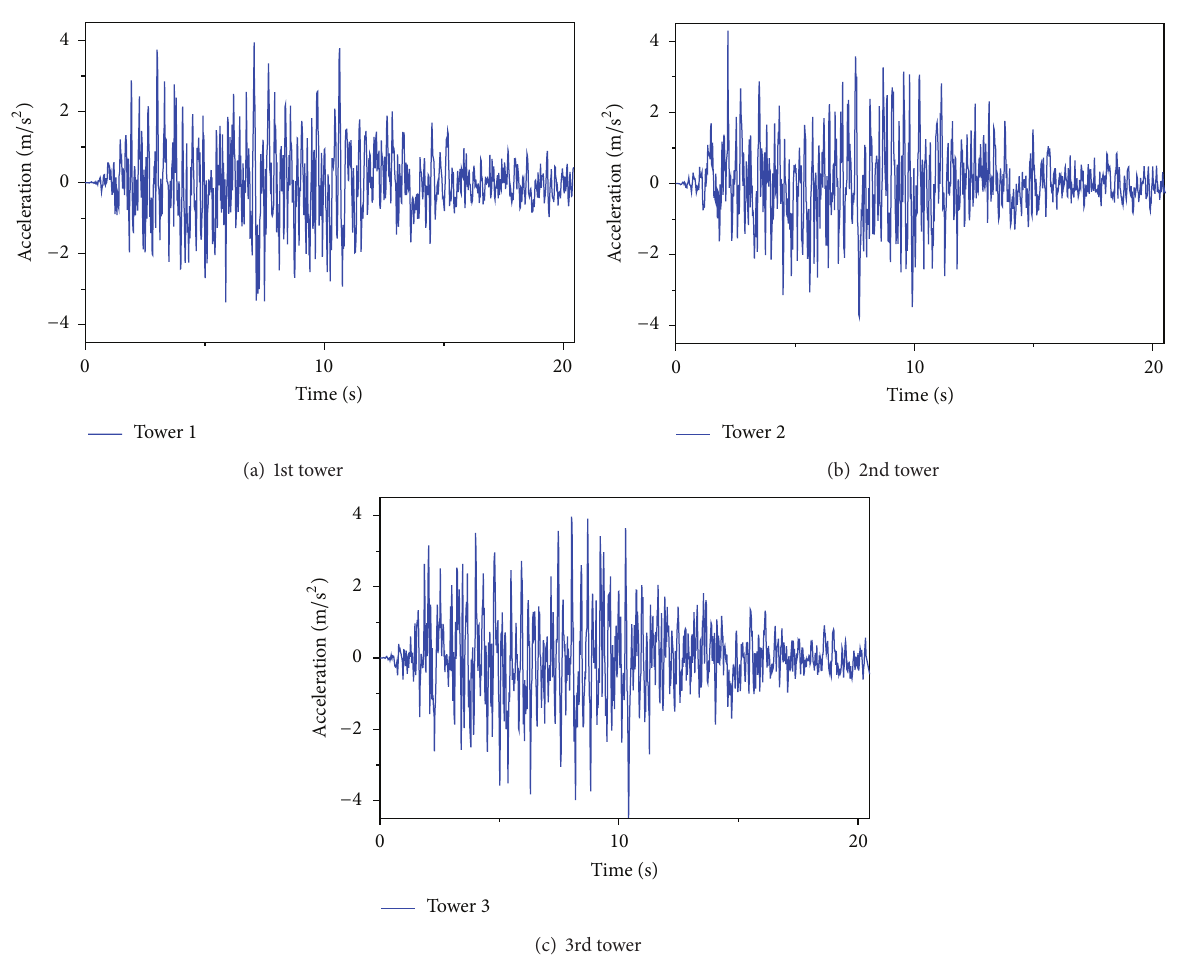
(c) 3rd tower Figure 3: Acceleration time histories of three tower points in longitudinal direction.